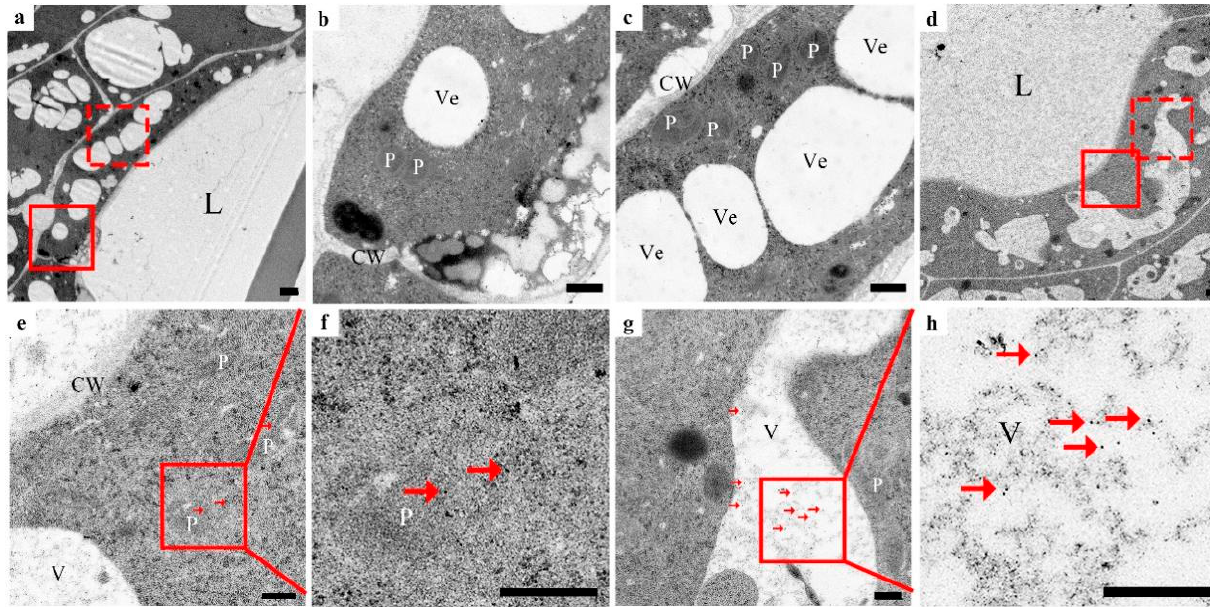
Figure 6. Zn 2+ ions subcellular localization ( a – c ) and CgENDO1 immunocytochemistry ( d – h ) during secretory cavity development of Citrus grandis ‘Tomentosa’ fruits. ( a ) Shows the innermost secretory cavity cells around the lumen in the lumen ‐ expanding stage. ( b ) Shows the solid line rectangle in ( a ). ( c ) Shows the dotted line rectangle in ( a ). There were no silver granules in the cell wall, vesicle, and cytoplasmic matrix. ( d ) Shows the innermost secretory cavity cells around the lumen in the lumen ‐ expanding stage. ( e ) Shows the solid line rectangle of ( d ); ( f ) shows the solid line rectangle of ( e ); a few gold particles remain in the plastids with unclear structures (arrow). ( g ) Shows the dotted line rectangle of ( d ); ( h ) shows the solid line rectangle of ( g ); there are very few gold particles in the vacuoles that were destroyed (arrow). CW: Cell wall; L: Lumen; N: Nucleus; NM: Nuclear membrane; Nu: Nucleolus; P: Plastid; V: Vacuole; Ve: Vesicle. Bars = 500 nm.